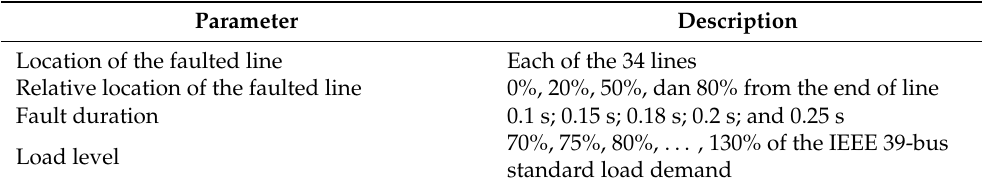
Table 1. Scenarios of variations in electric power system operating conditions.